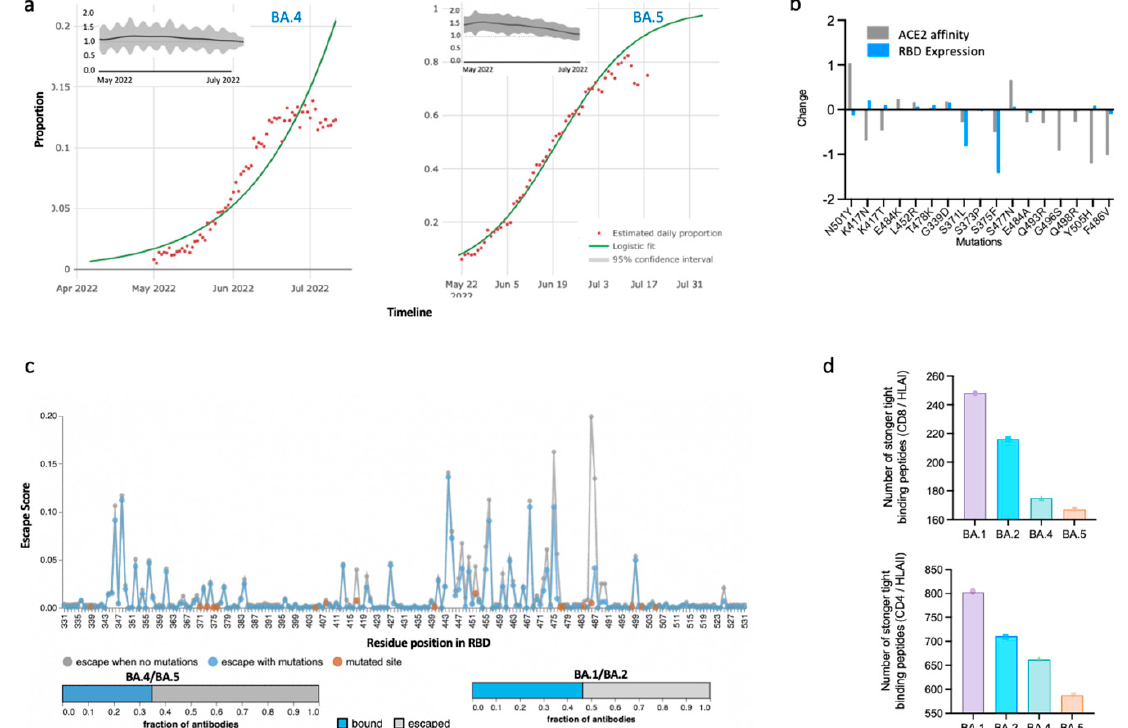
Figure 1. Characteristics of Omicron BA.4 and BA.5 variants. ( a ) Relative growth advantage of the BA.4 and BA.5 variant obtained by the logistic fitting of the proportion of SARS-CoV-2 variant se- quences globally. The relative growth advantage estimates are based on the proportion of the specific variant (BA.*)-positive sequences over a period of time as compared to cocirculating strains. The model assumes that the current advantage is due to a transmission advantage, which is contributed to by the immune evasion capabilities, transmission characteristics, or prolonged infection time. Adapted from Chen C et al. [4]. The insets depict temporal variations in the current reproduction number along the emergence of BA.4 or BA.5 variants. ( b ) Effects of RBD mutations on ACE2 binding affinity (gray) and RBD expression in S protein. Adapted from Starr TN et al. [12]. ( c ) Prediction of immune escape and polyclonal antibody evasion upon mutations in ancestral SARS-CoV-2. Orange dots indicate mutations in RBD. The horizontal stacked bar graph shows the fraction of polyclonal antibodies which can bind or escape from the BA.4/5 omicron variant (Left) and BA.1/2 variants (Right). Adapted using “Escape calculator for SARS-CoV-2 RBD” [13]. ( d ) Number of strongly tight binding peptides to HLA 1 and HLA II in the BA.1, BA.2, BA.3, and BA.5 variants. Adapted from Nersisyan et al.